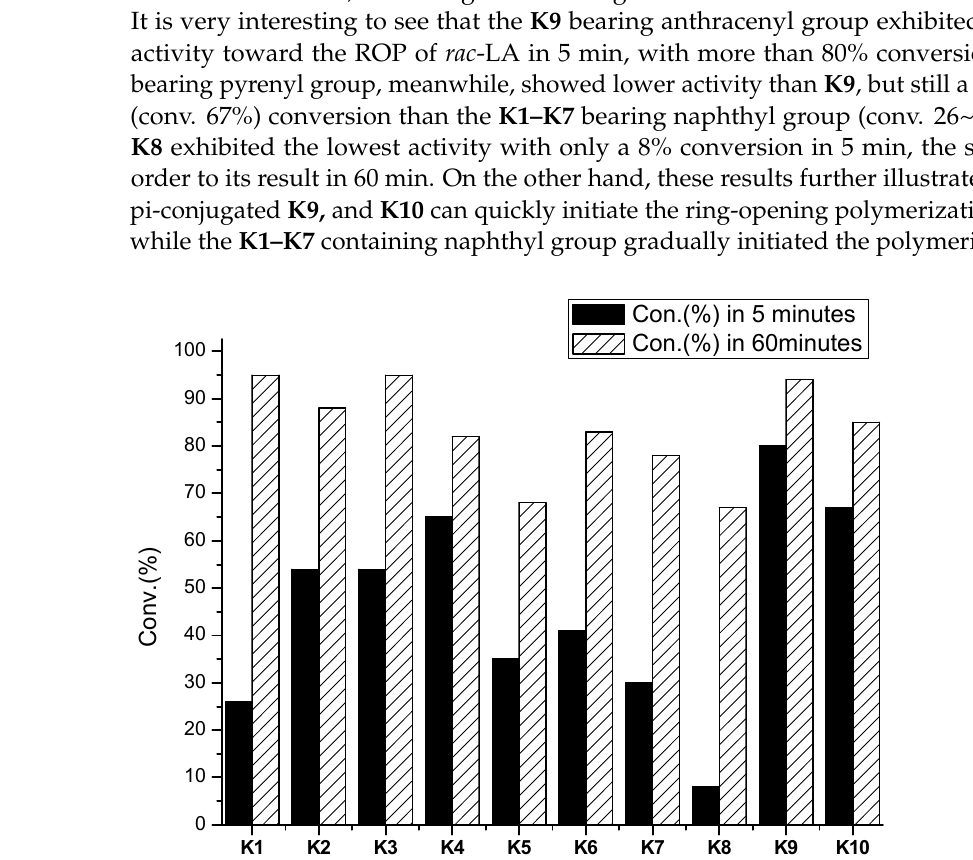
Figure 8. Comparing the conversion by K1 – K10 in 5 or 60 min. As the substituent of potassium complexes greatly affected their polymerization activity, their influence on isoselectivity toward ROP of rac -LA was also investigated. We found that, generally, the isoselectivity of PLA in 5 min were much better ( P m : 0.61~0.76) than that obtained in 60 min ( P m : 0.54~0.68) (shown in Figure 9), which may be due to the increasing side reaction in the longer time.